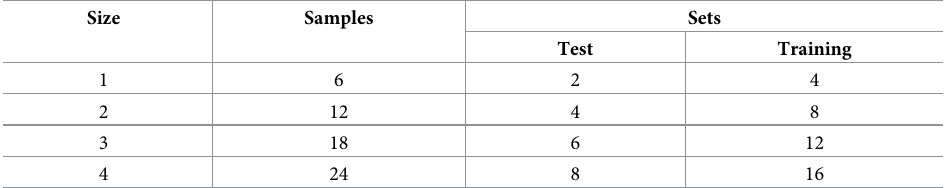
Table 7. Distribution for training and test